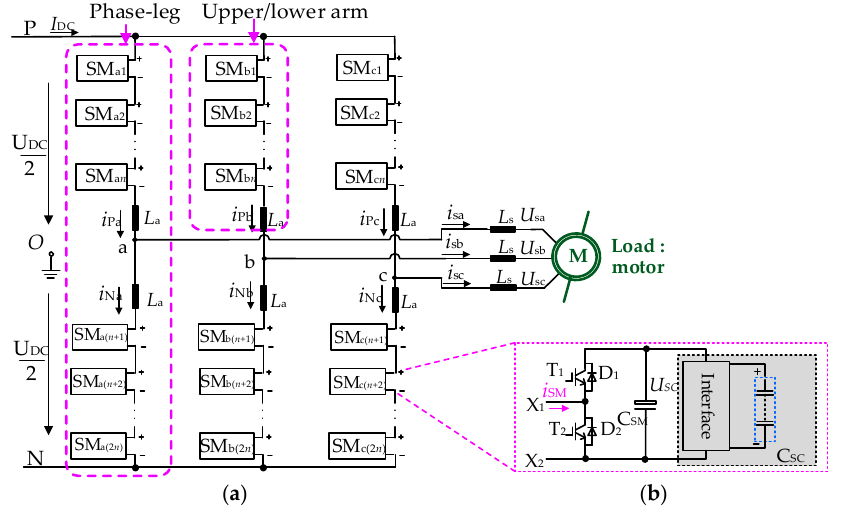
Figure 1. Configuration of three-phase SCES-MMC and its sub-module: ( a ) Three-phase SCES-MMC topology; ( b ) SCES-SM.